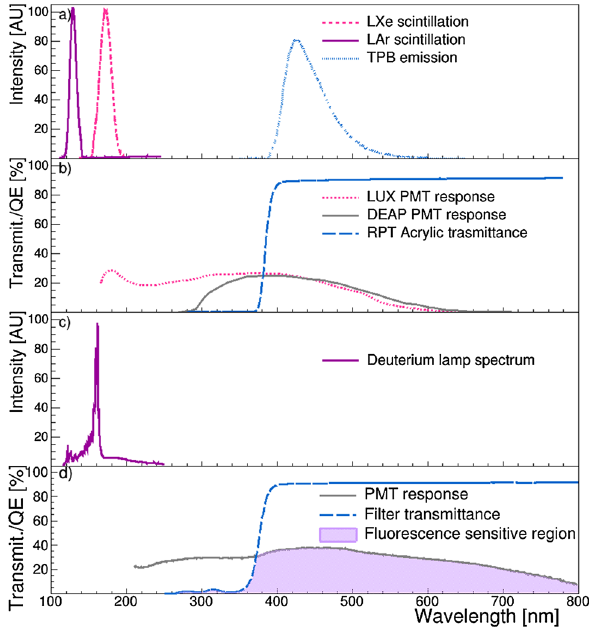
Fig. 2 a Emission spectra of LXe [33], LAr [9], and TPB (this work). b Quantum efficiencies of the Hamamatsu R8778 PMT used in LUX [34] and the Hamamatsu R5912 PMT used in DEAP-3600 [35]. Also shown is the transmittance of a 110mm thick sample of RPT acrylic used in DEAP. c Spectrum of a deuterium lamp. d Response of the PMT used in this work (combined with the optical fiber) and transmittance of the acrylic filter. The transmittance of the lens was considered to be flat above 200nm and is not shown here. The shaded area indicates the wavelength region our photon detection setup is sensitive